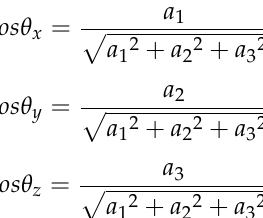
The method of calculating the inclination from the X-axis is to calculate vector (cid:126) b as vector ( 1, 0, 0 ) in the X-axis direction, which is expressed in Equation (4). Similarly, the method of calculating the inclinations from the Y-axis and X-axis is to calculate vector (cid:126) b as vector ( 0, 1, 0 ) and ( 0, 0, 1 ) in the Y-axis and Z-axis directions, which is expressed in Equations (5) and (6),